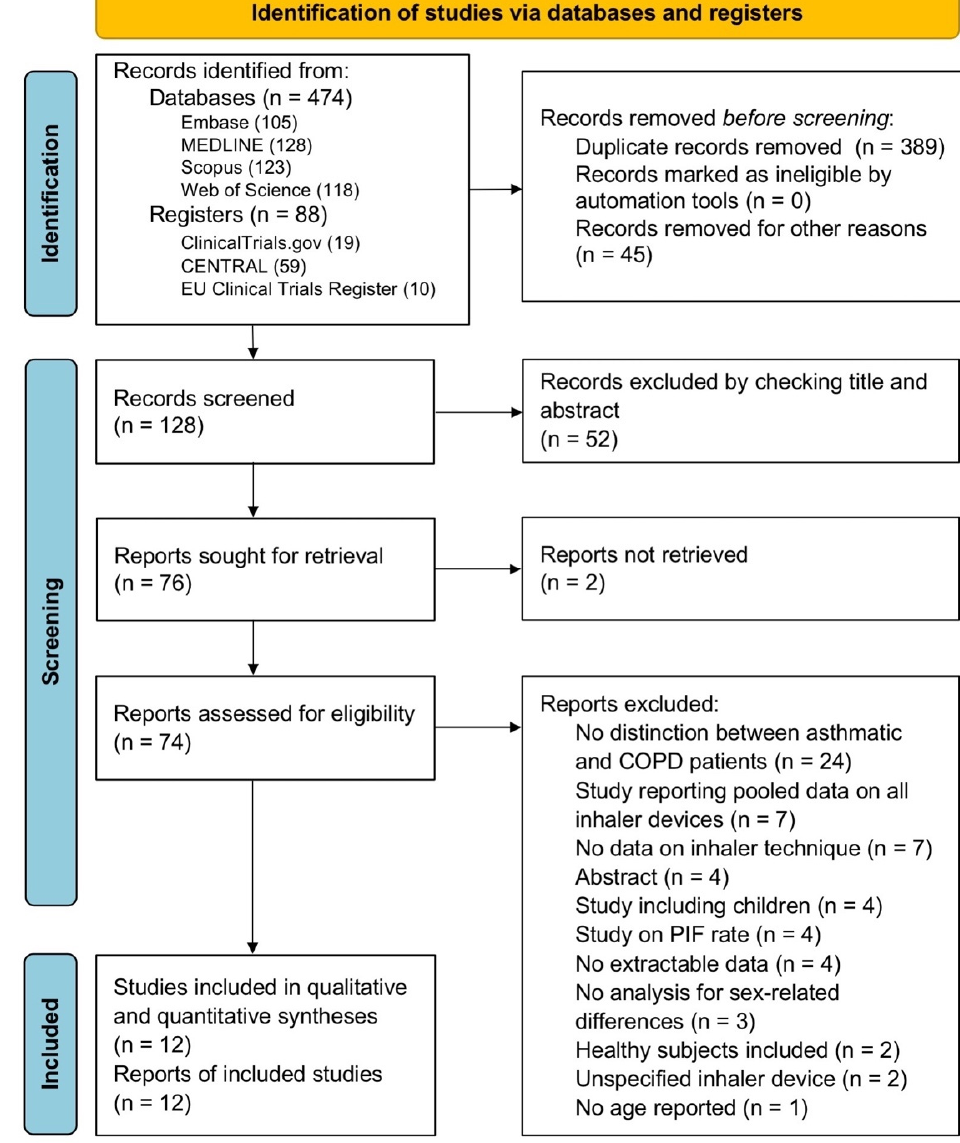
Figure 1. PRISMA 2020 flow diagram for the identification of the clinical studies included in the qualitative and quantitative syntheses. CENTRAL: Cochrane Central Register of Controlled Trials; PIF: peak inspiratory flow; PRISMA: Preferred Reporting Items for Systematic Reviews and Meta-Analyses.